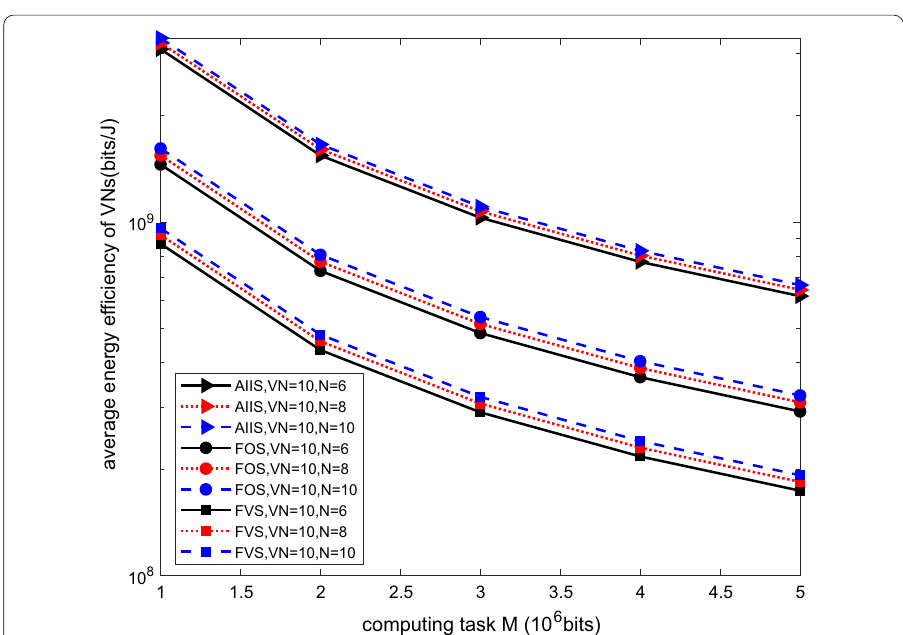
Fig. 4 The average energy efficiency of vehicle nodes (VNs) versus the computation task M under different antenna numbers